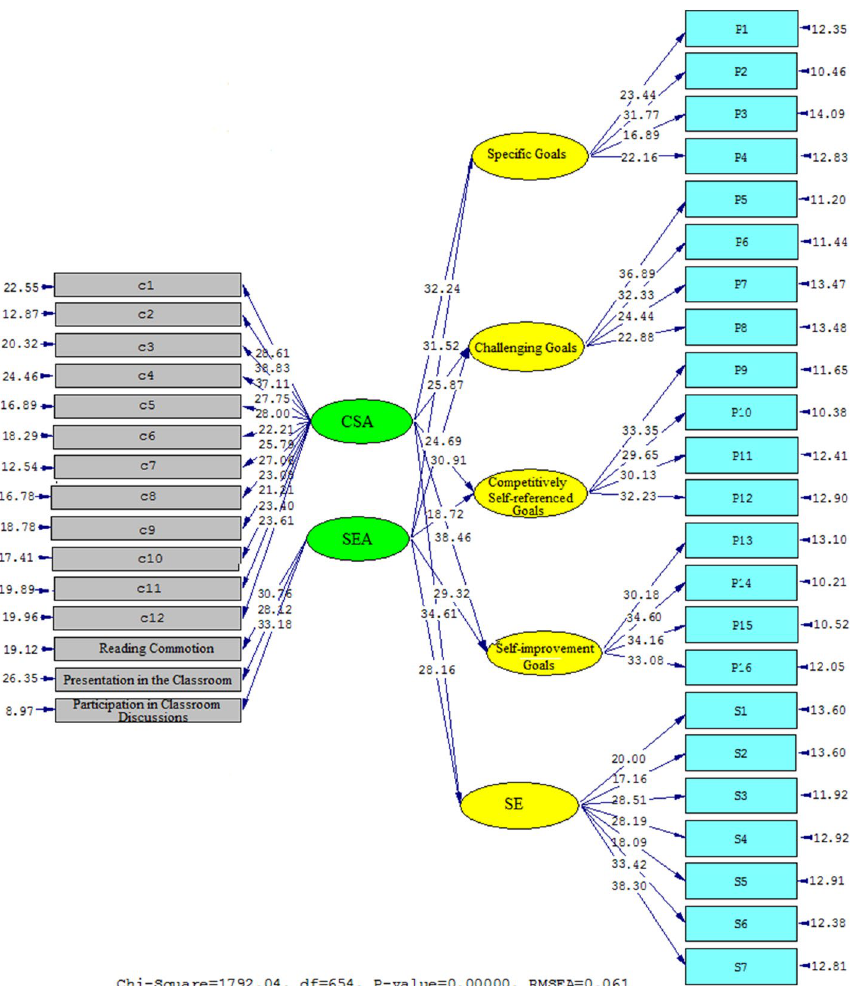
Fig. 5 T values for path coefficient significance (model